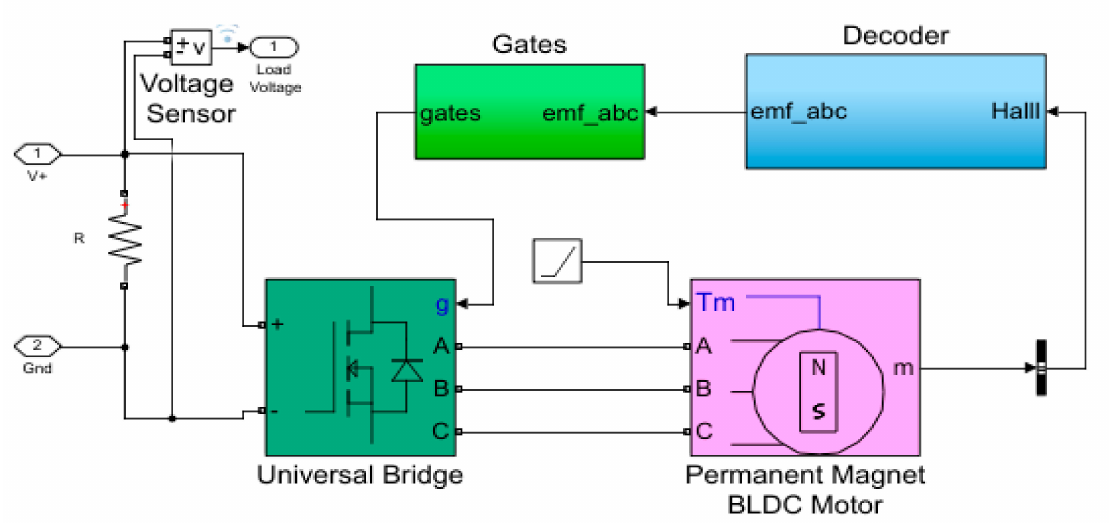
Figure 3. Simulink model of brushless DC (BLDC) motor.